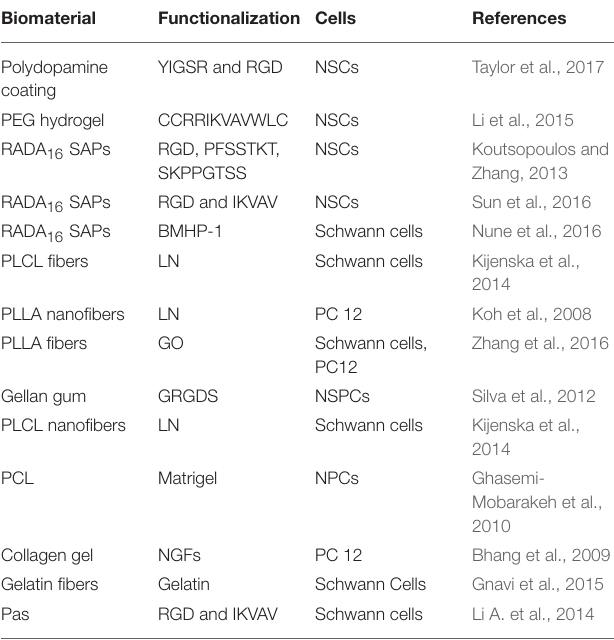
TABLE 1 | Biomaterial scaffold for neural cell